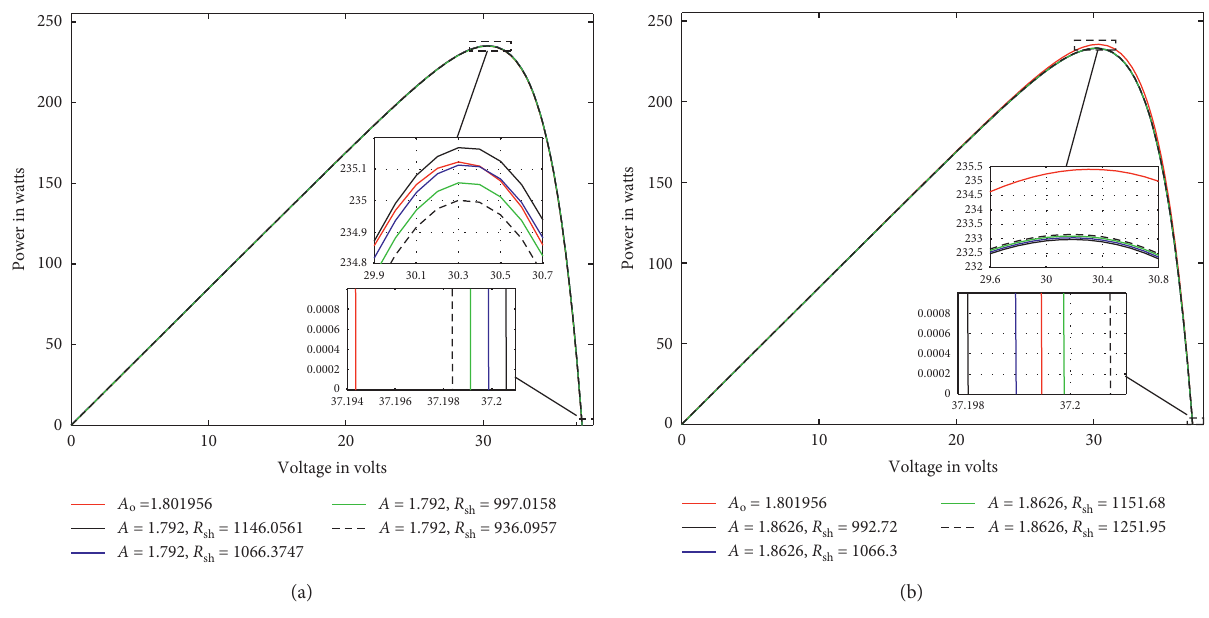
Figure 5: PV curves for BP3235T showing different ( R